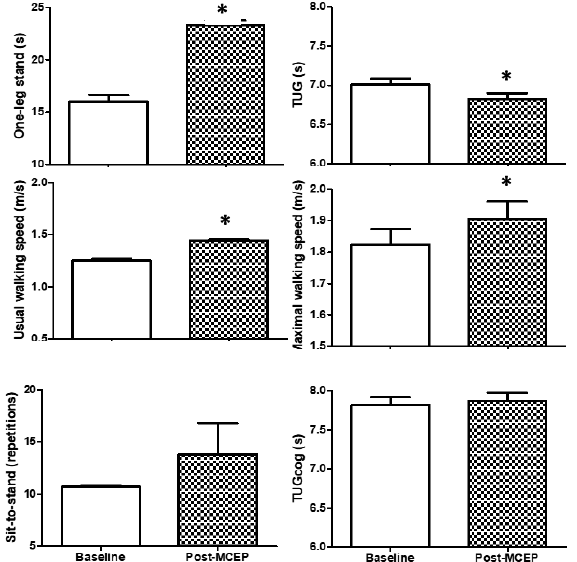
Figure 2. Physical and executive functions. Values are mean ± S.D. TUG, Timed “Up and Go”; TUGcog, TUG with a cognitive task; * p < 0.05 versus baseline. Table 2. ES of functional, cognitive, and hemodynamic parameters.